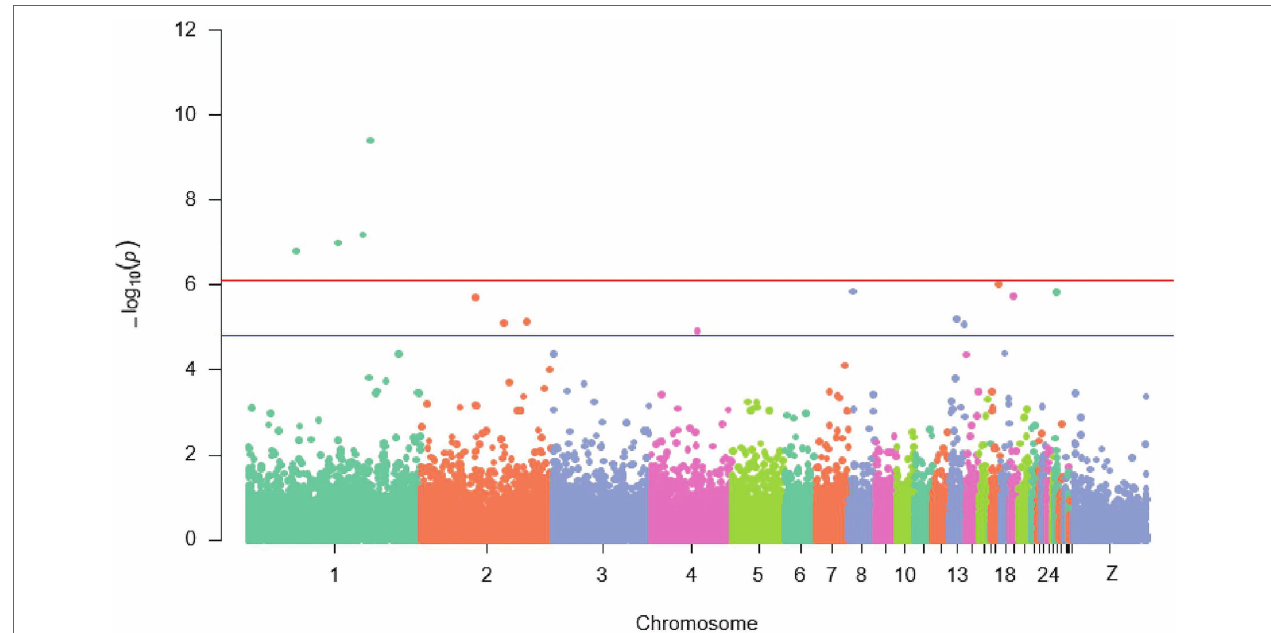
FIGURE 3 | Manhattan plot displaying significant and suggestive SNPs associated with antibody response to Newcastle disease {the red line designates a Bonferroni-adjusted genome-wide threshold [ − log10 ( p ) ≥ 6.1] and the blue line indicates a suggestive